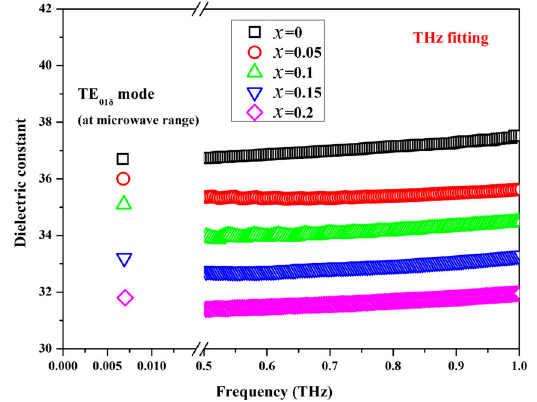
Fig. 6 Absorption coefficients of ZnTi 1– x (Al 0.5 Nb 0.5 ) x Nb 2 O 8 ceramics at 0.6 and 0.9 THz. Reproduced with permission from Ref. [135], © The American Ceramic Society 2019.